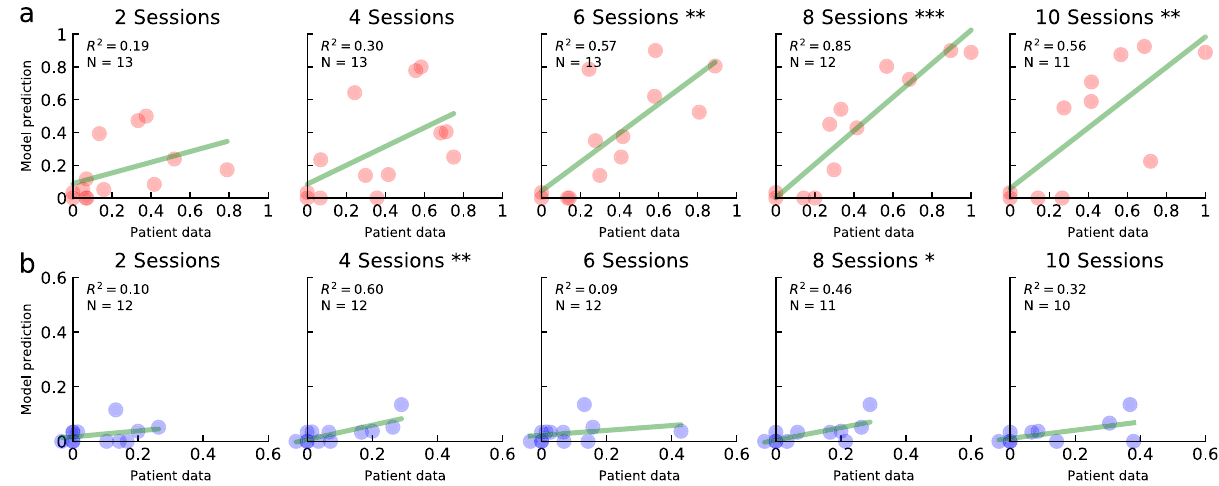
Figure 7. Regression models of treatment response for all patients at different times during treatment. As treatment progresses from left to right, model predictions ( y -axis) become increasingly predictive of patient data ( x -axis) in the treated ( a ) and untreated ( b ) language at different significance levels (* p ≤ 0.05 ; ** p ≤ 0.01 , *** p ≤ 0.001